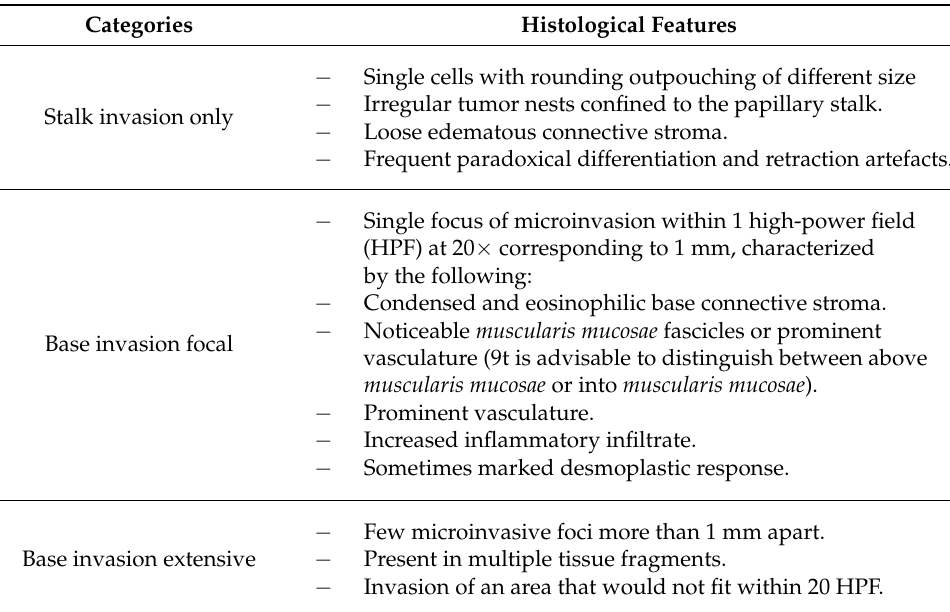
Table 1. Papillary urothelial carcinomas (pT1) with invasion of lamina propria